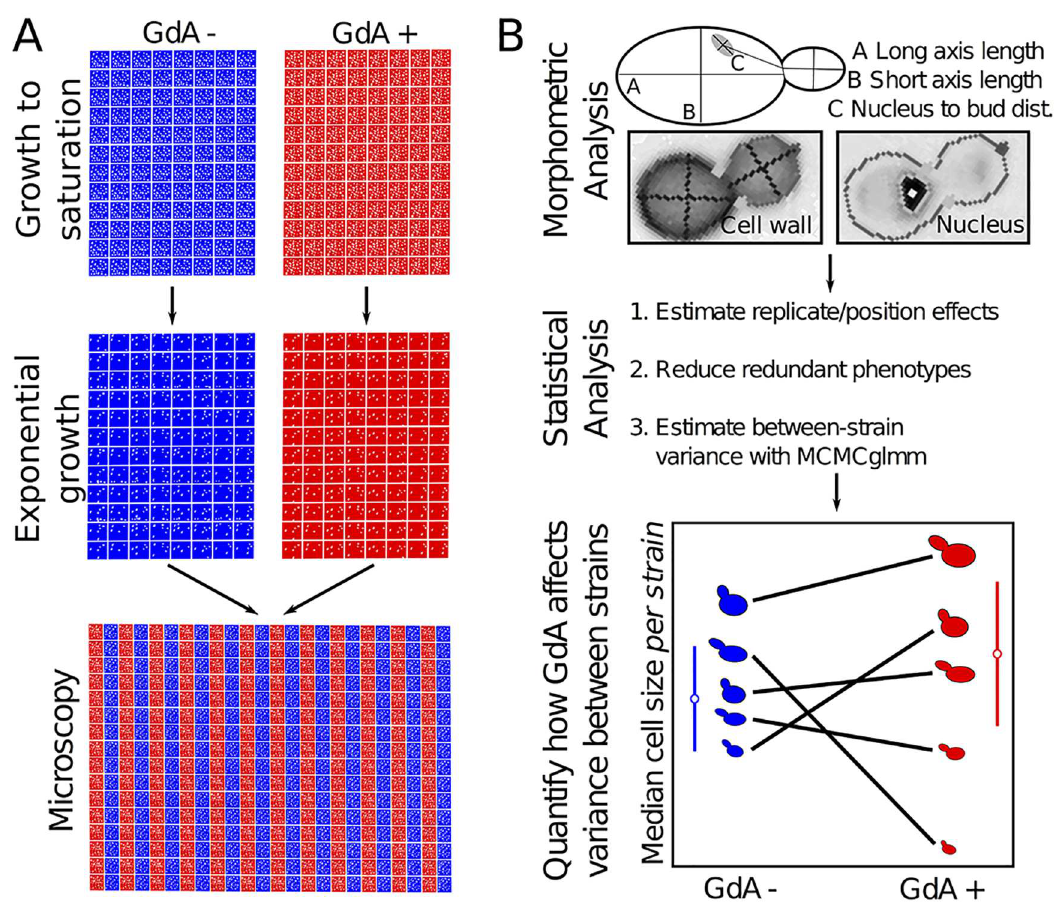
Fig 2. Experimental design. This figure outlines the experimental (A) and analytical (B) procedures used to quantify variation in morphological traits with and without Hsp90 inhibition(see S1 Text and S1